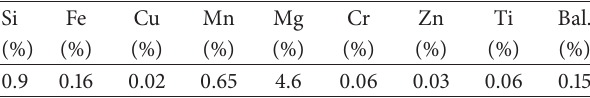
Figure 3: Fixture assemblies for the FSP tests.